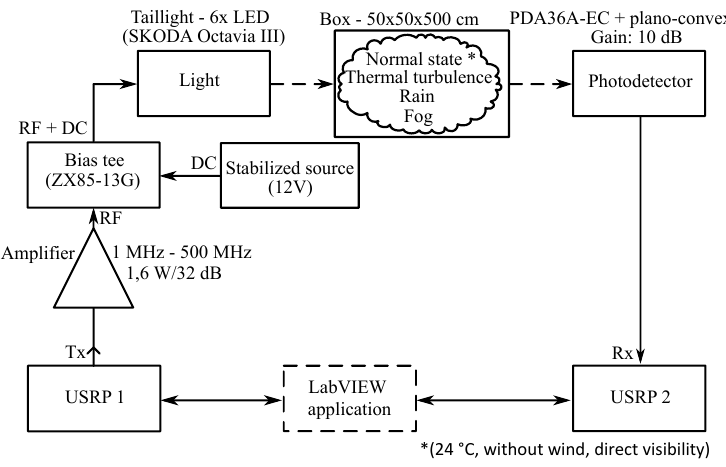
Figure 12. Octavia tail-light setup.